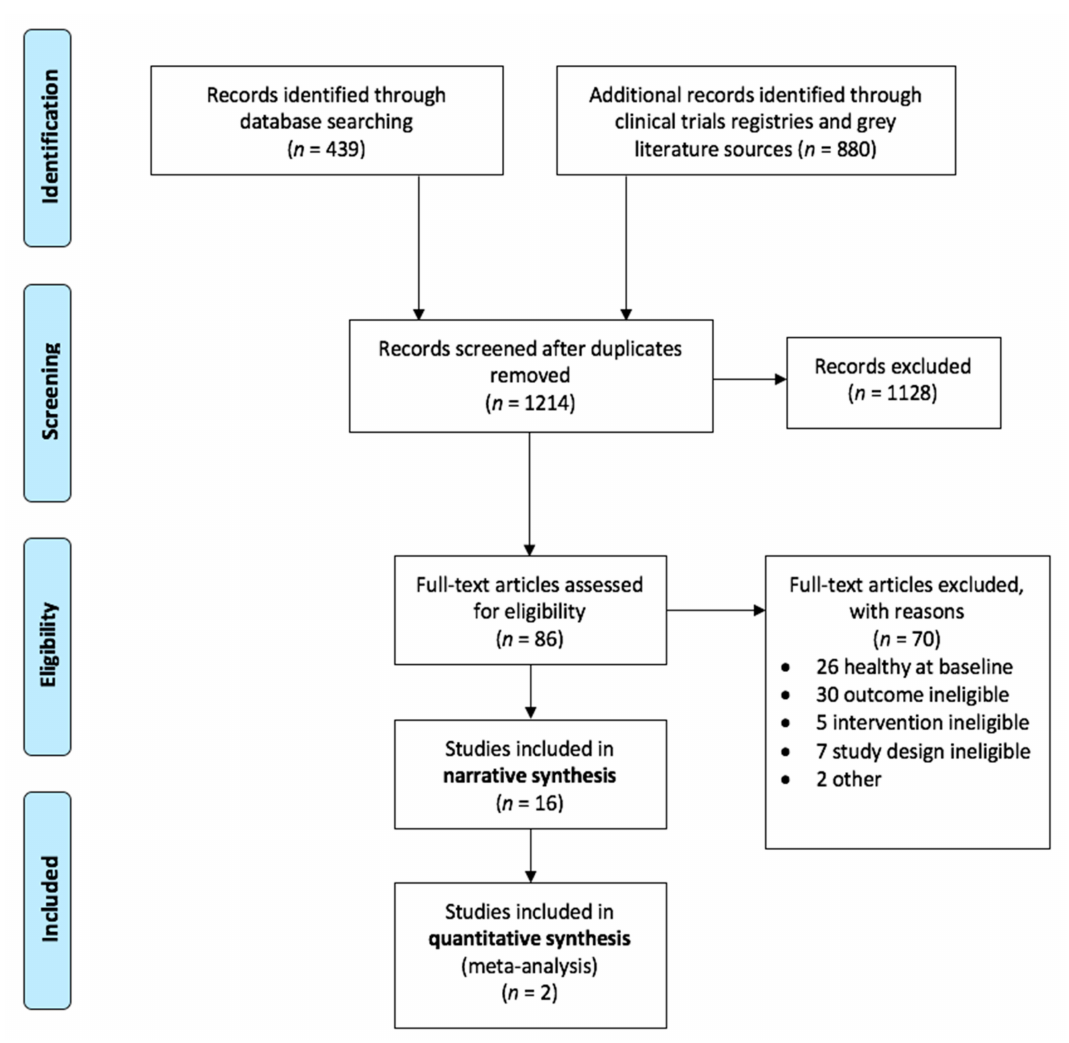
Figure 1. Systematic review and meta-analysis of multinutrients for psychiatric symptoms. PRISMA (The Preferred Reporting Items for Systematic Reviews and Meta-Analyses) flow